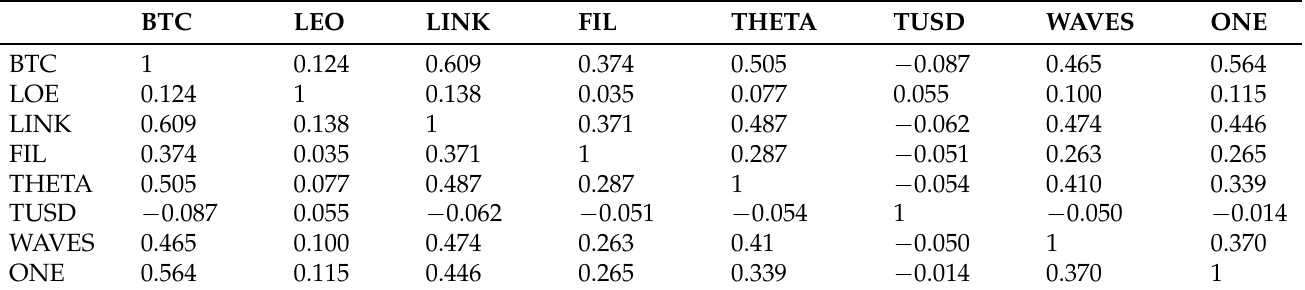
Table 6. Correlation coefficients.